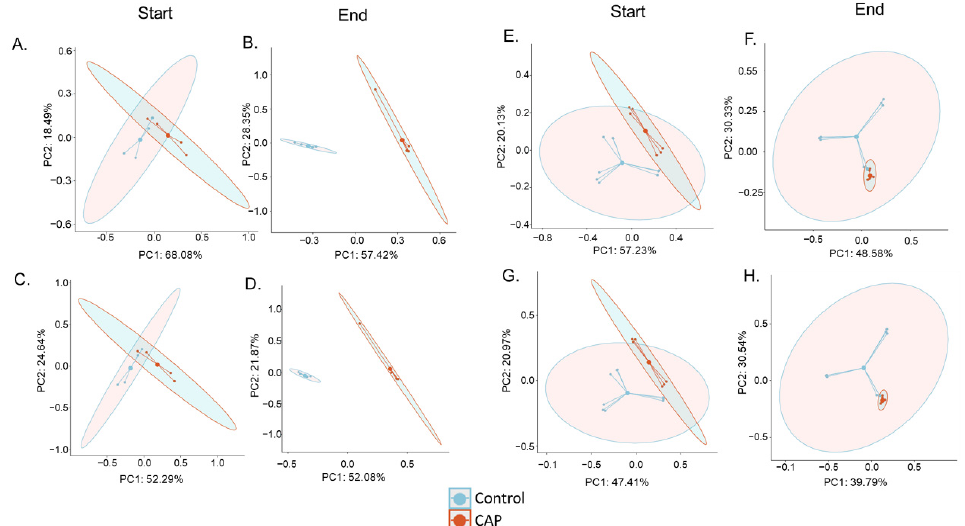
Figure 2. Beta Diversity of the CAP Start and CAP End phases. ( A ) C1 Bray–Curtis PCoA Start of Treatment (NS), ( B ) C1 Bray–Curtis PCoA End of Treatment ( p < 0.001), ( C ) C1 Jaccard Index PCoA Start of Treatment (NS), ( D ) C1 Jaccard Index PCoA End of Treatment ( p < 0.01), ( E ) C2 Bray–Curtis PCoA Start of Treatment ( p < 0.05), ( F ) C2 Bray–Curtis PCoA End of Treatment ( p < 0.05), ( G ) C2 Jaccard Index PCoA Start of Treatment ( p < 0.05), and ( H ) C2 Jaccard Index PCoA End of Treatment ( p < 0.001). Significance was determined using